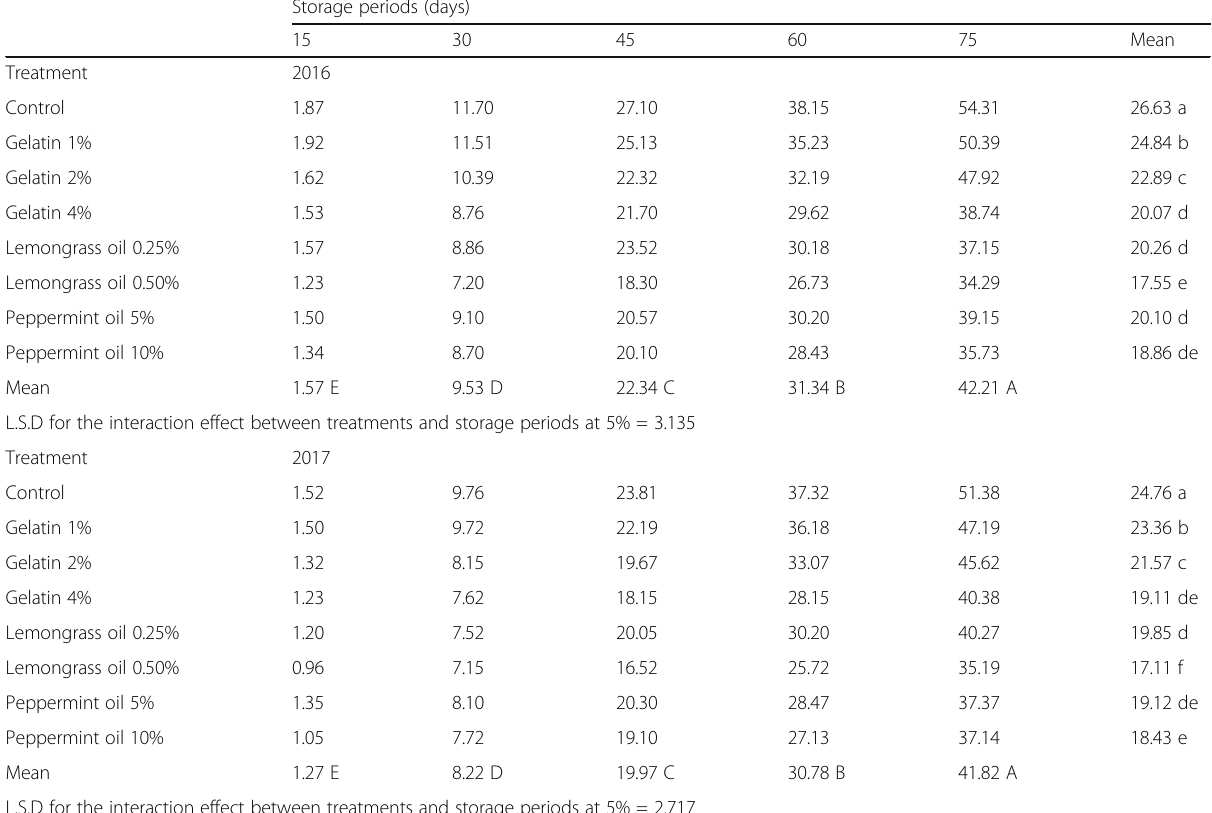
Table 2 Effect of gelatin, lemongrass oil, and peppermint oil on decay (%) of Samany date palm fruits stored at 0.0 °C ± 2 during two experimental seasons Storage periods